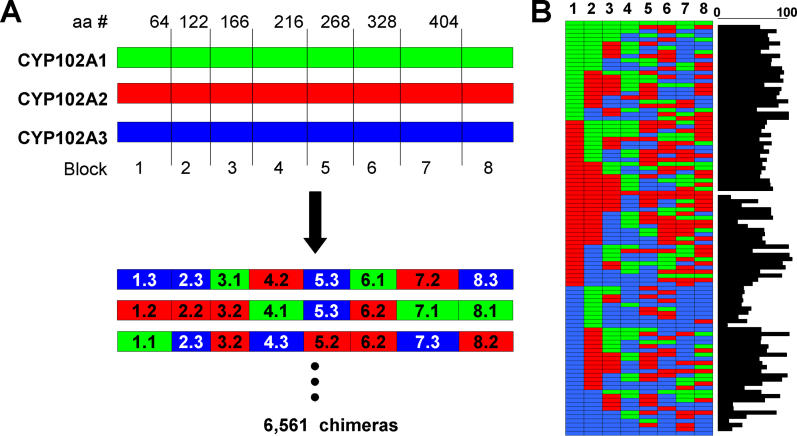
Diverse Chimeras Created by Site-Directed Recombination(A) Site-directed recombination of three bacterial cytochromes P450 showing crossover sites chosen to minimize the number of disrupted contacts (number is last residue of the sequence block according to CYP102A1 numbering). Blocks are assigned numbers 1 through 8 and three fragments are possible at each block. Three example chimeras are shown to illustrate the fragment nomenclature, e.g., fragment 1.3 is block 1 inherited from parent A3.(B) Sequences of three parents and 97 folded P450 chimeras and number of amino acid changes relative to the closest parent (bar on right).